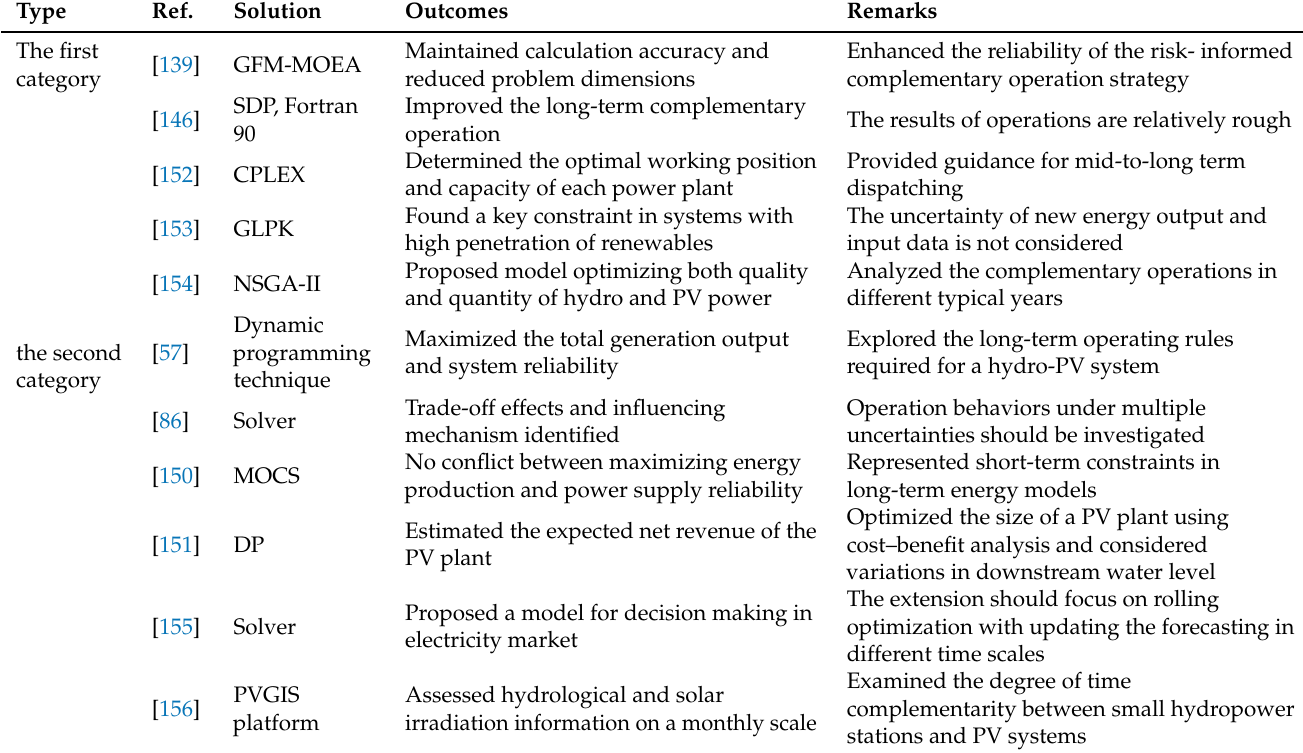
Table 3. Summary of reviewed articles to show the status of long-term